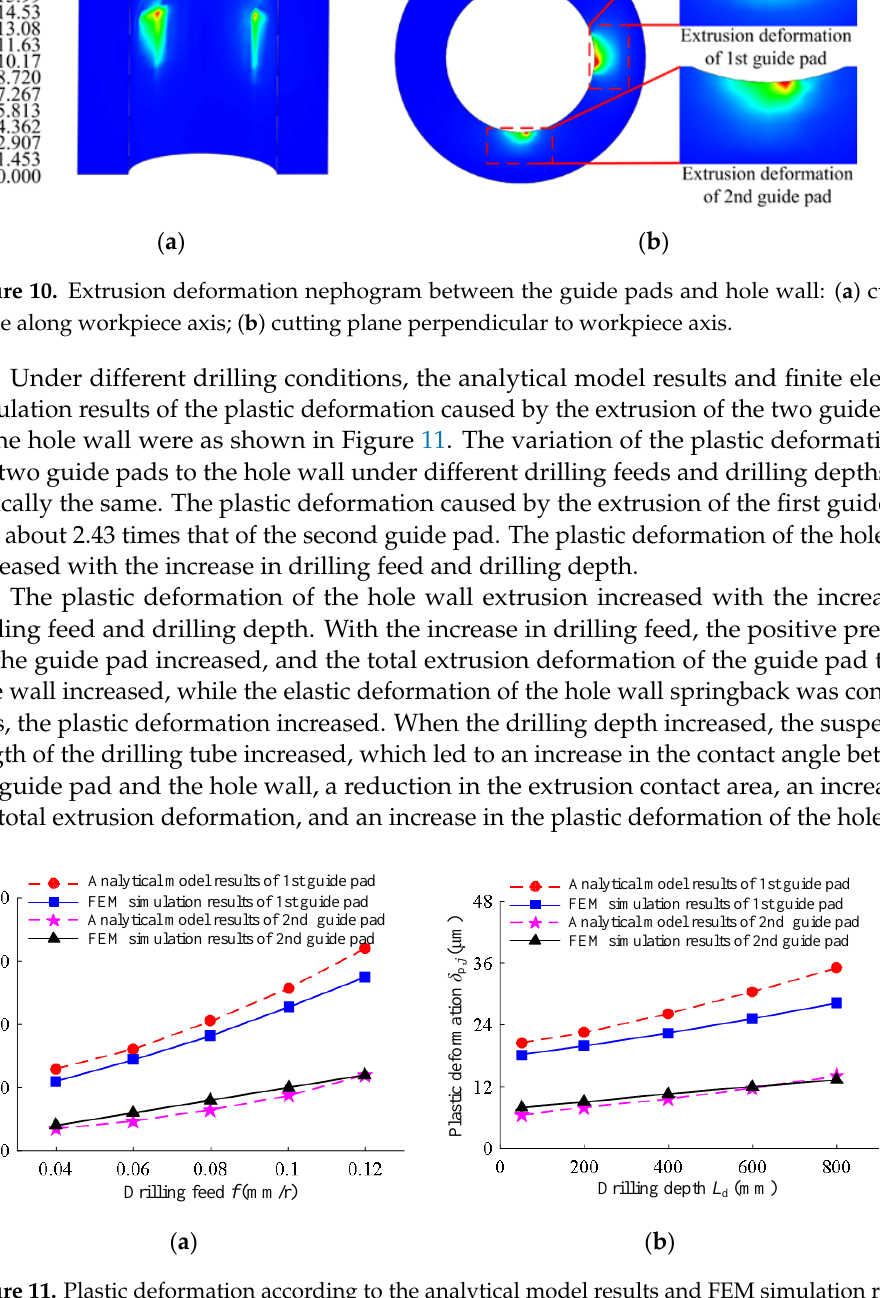
( c ) Figure 12. Equipment for deep hole machining tests: ( a ) deep hole machining machine; ( b ) work- piece; ( c ) ∅ 17.75 BTA drill. 4.2. Model Validation